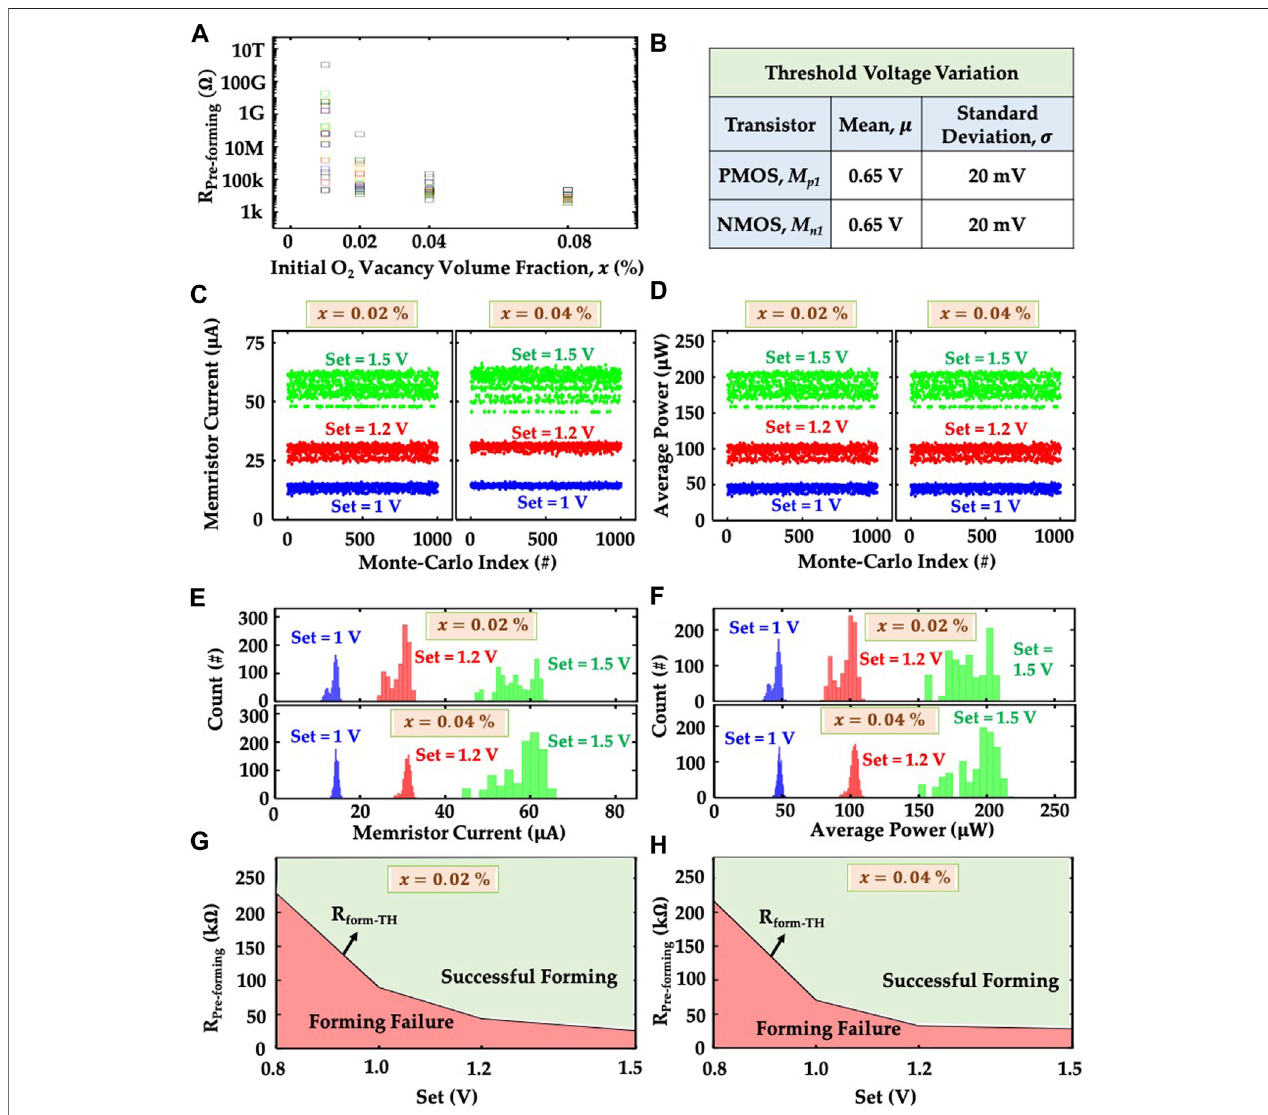
FIGURE 9 | (A) Dependence of pre-forming HRS on the initial oxygen vacancy volume fraction (x). These results are obtained from KMC-TCAD simulation for 25 devices. (B) Tableshowsthevaluesofmeanandstandarddeviationofthethreshold voltagedistribution of M p 1 and M n 1 transistorsusedfortheMonte-Carlosimulation. Scatter plot of the (C) memristor current, and (D) average power consumption of the forming circuit obtained from the 1,000 point Monte-Carlo simulation for three different values of Set (1 V , 1.2 and 1.5 V ) and the pre-forming HRS values for two different values of x (0.02 and 0.04 % ). Histogram plot of the (E) memristor current,and (F) averagepowerconsumptionoftheformingcircuitforthedatashowninthescatterplotsof (C) and (D) respectively.Dependenceofformingsuccessand failure on the values of Set for the pre-forming HRS values obtained for (g) x (cid:2) 0.02 % , and (h) x (cid:2) 0.04 % .